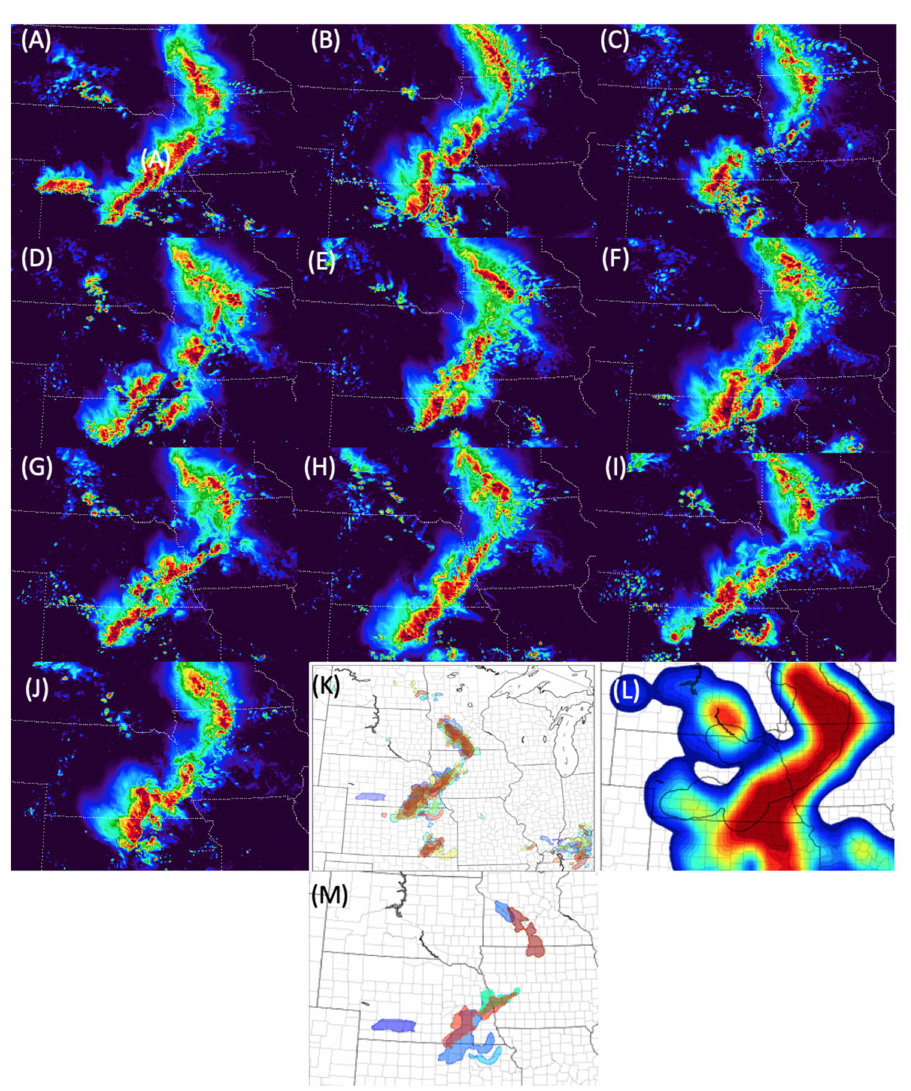
Figure 2. ( A – J ) Ten-member Nonhydrostatic Multiscale Model on the B grid (NMMB) ensemble forecast initialized 00 Z, 7 July 2016, valid at 06 Z 7 July 2016, ( K ) corresponding paintball, ( L ) neigh- borhood maximum ensemble probability (NMEP), and ( M ) OBPROB